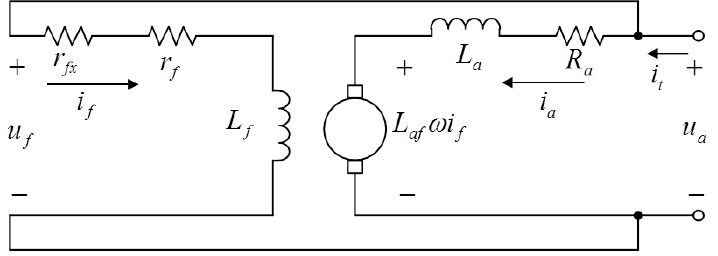
Figure 1. Equivalent circuit of a direct current shunt